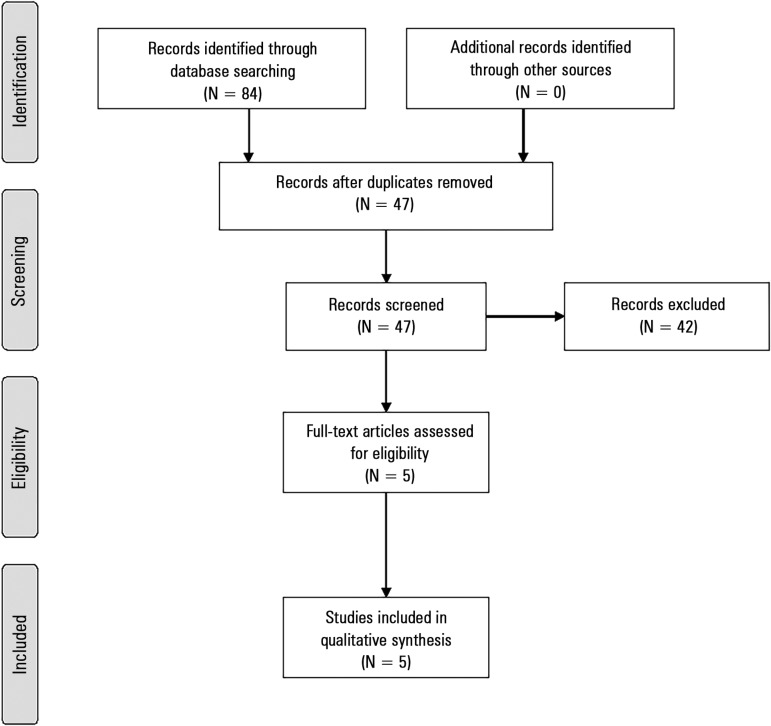
Study flowchart.